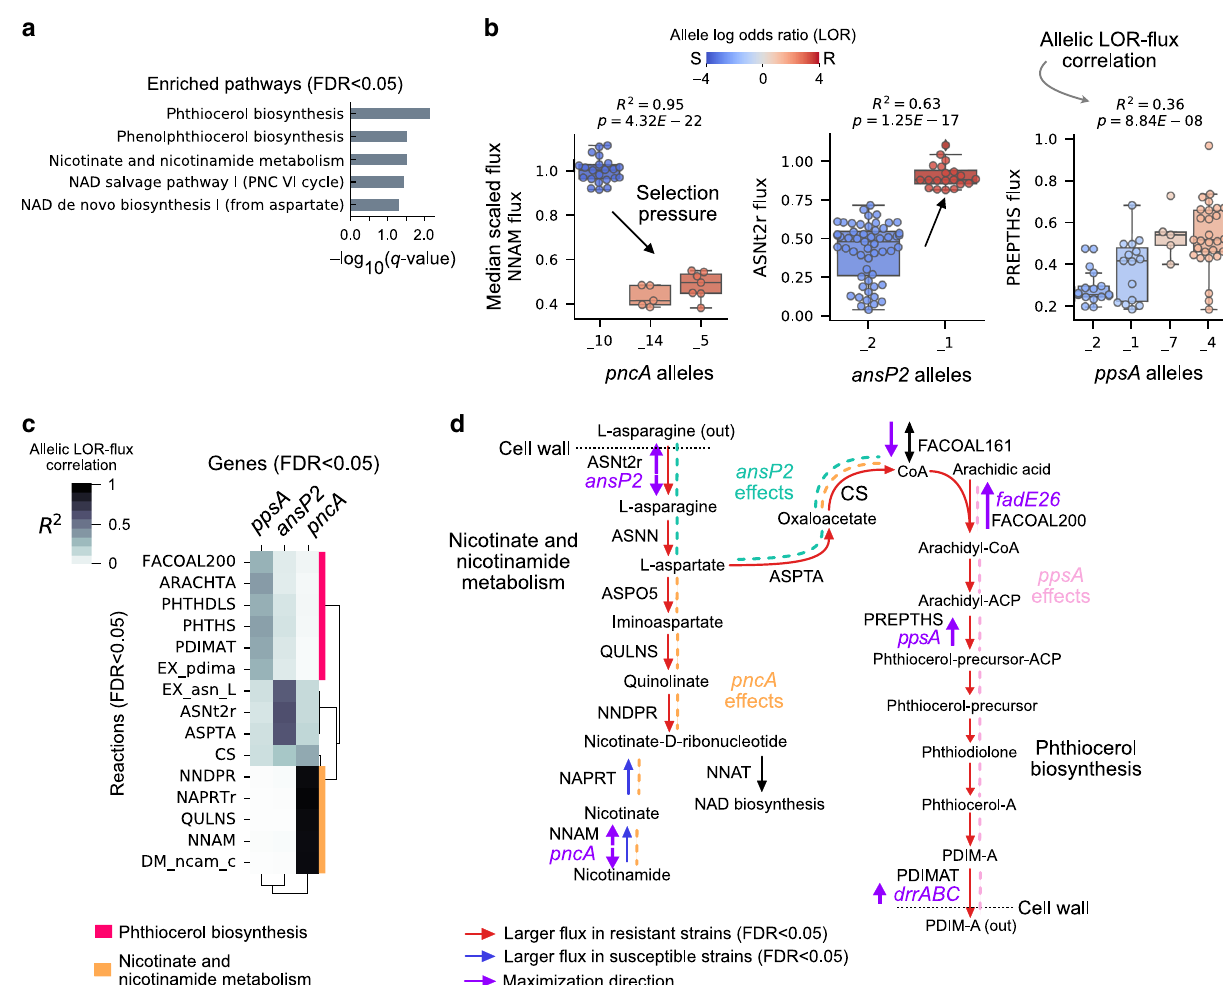
Fig. 3 Characterization of pyrazinamide MACs. a Horizontal bar plots of pathways enriched with signi fi cant pyrazinamide-associated fl uxes with FDR < 0.05. b Boxplots of pncA , ansP2 , and ppsA allele-speci fi c fl uxes for the reactions catalyzed by their gene-products. Alleles are rank ordered from least to greatest by their log odds ratio (LOR), from left to right. The boxes are colored according to the allele LOR, where positive corresponds to resistant (R) dominant while negative corresponds to susceptible (S) dominant. The box shows the quartiles of the dataset with the median noted as the horizontal line while the whiskers extend to show the rest of the points with outliers colored gray. The R -squared and P -value for the regression between allele LOR and fl ux is noted. See Supplementary Data 3 for list of mutations per allele. c Clustered heatmap of allele LOR- fl ux correlations between genes ( y -axis) and signi fi cant reactions fl uxes ( x -axis). d Pathway depiction of nicotinate and nicotinamide metabolism and phthiocerol biosynthesis with objective variables plotted. Coenzyme-A generation from L-asparagine through aspartate decarboxylase (ASPTA) and citrate synthase (CS) is also depicted. Traced allelic effects are shown as dashed lines and colored for pncA , ansP2 , and ppsA